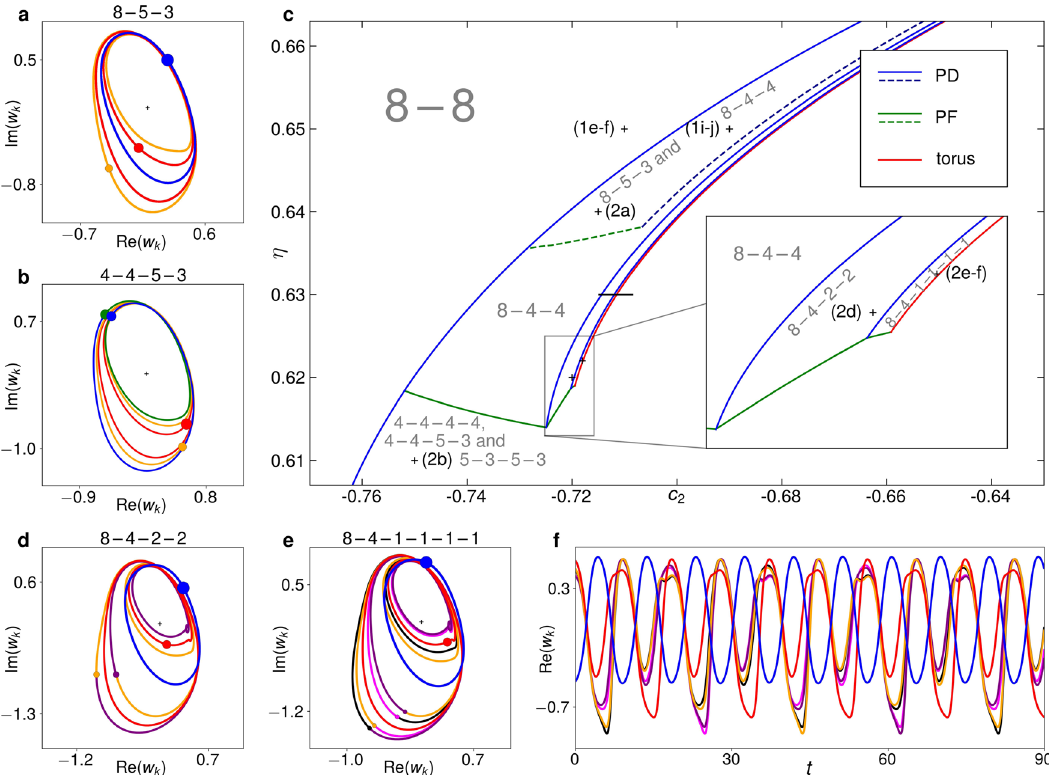
Fig. 2 Cluster solutions and bifurcations for N = 16. Each fi lled circle refers to the instantaneous position of a cluster or single oscillator, the line of the respective same colour to its trajectory. Sizes of fi lled circles mirror sizes of clusters. a 8 − 5 − 3 solution in the co-rotating frame of 〈 W 〉 for c 2 = − 0.715 and η = 0.64. b 4 − 4 − 5 − 3 solution for c 2 = − 0.75 and η = 0.61. c Bifurcation diagram of 8 − 8-derived solutions with PD period-doubling, PF pitchfork. Dashed lines mark bifurcations of the 8 − 5 − 3 solution ( a ), solid lines those of the 8 − 4 − 4 (Fig. 1i-j) and the solutions emerging from it. Grey labels mark where each type of solution is stable. Labeled crosses mark the parameter values of the solutions depicted in Fig. 1e, f, i, j, a , b and d – f . The black line marks the c 2 -incremented simulation in Fig. 3a, b. d 8 − 4 − 2 − 2 solution for c 2 = − 0.72 and η = 0.62. e , f 8 − 4 − 1 − 1 − 1 − 1 solution for c 2 = − 0.718 and η = 0.62, including time series of real part of each cluster and single